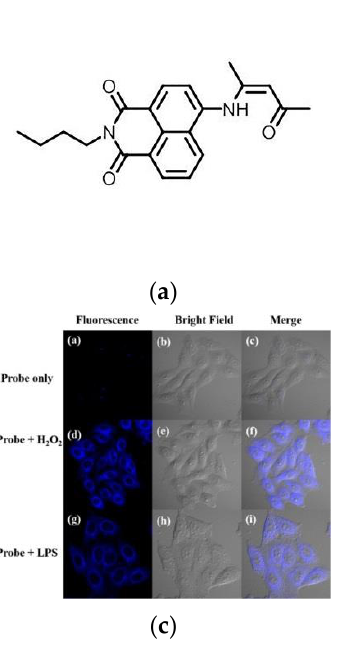
Figure 31. ( a ) Structure of probe GC-2; ( b ) Fluorescence response of GC-2 upon addition of H 2 O 2 ; ( c ) One-photon images of HepG2 cells. Reproduced with permission from [137]. Copyright 2017 Elsevier B.V.